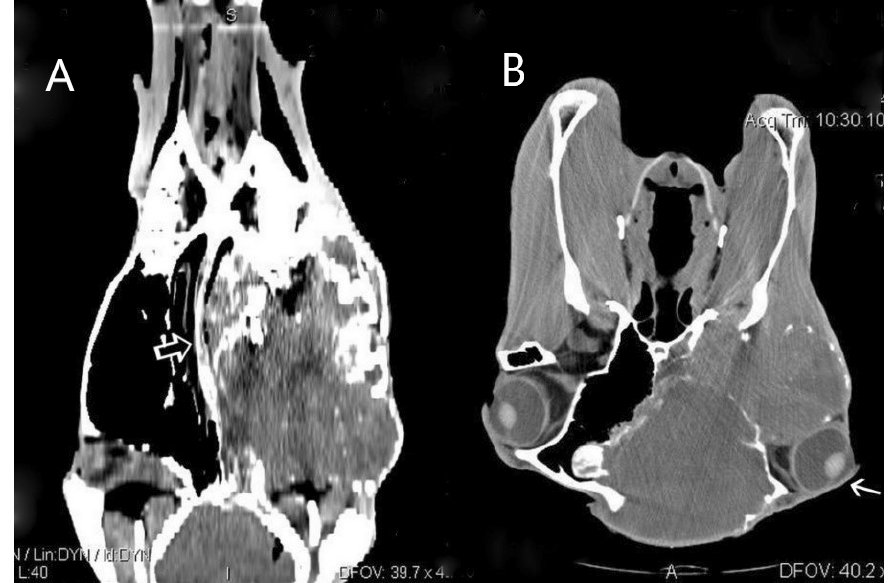
Figure 3. Tomographic examination of a six-year-old donkey. (A) Longitudinal multiplane reconstruction, soft-tissue window: irregular, heterogeneously contoured mass, extending from the rostral region of the left nasal cavity to the left conchofrontal sinus. There is displacement of the nasal septum to the right (arrow), with loss of definition and destruction of the other osseous structures of the nasal cavity; (B) Tomographic image in cross-section, in a soft-tissue window in which left exophthalmia (arrow) and adjacent soft tissue impairment are